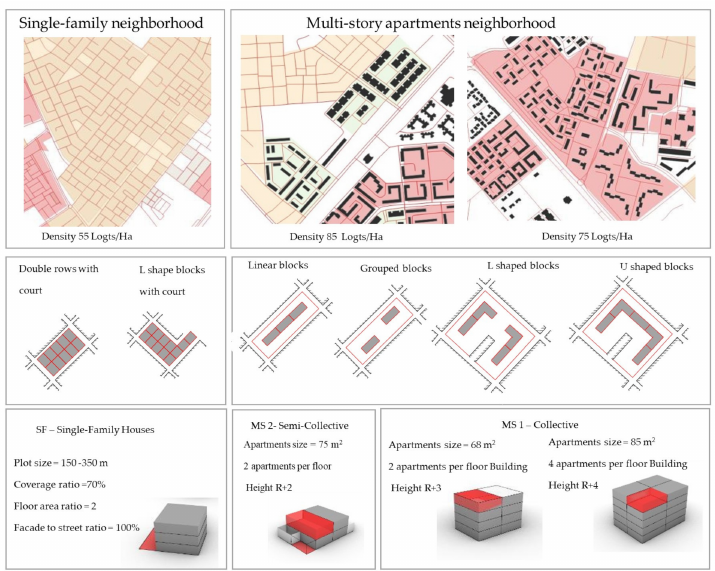
Figure 4. Characteristics of residential typologies in